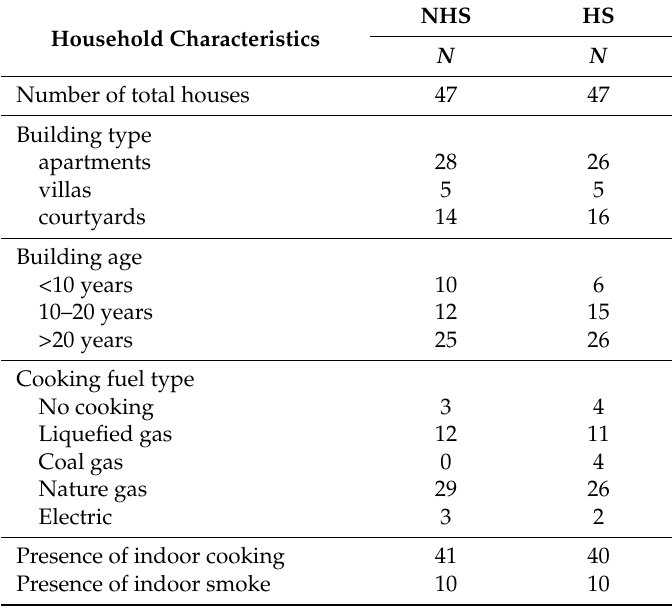
Table 1. Household characteristics of residential houses in this study.